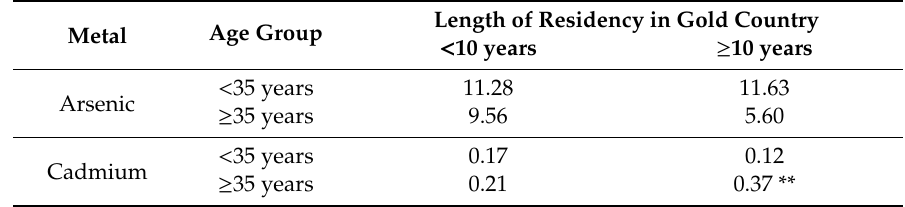
Table 4. Geometric Mean Arsenic and Cadmium levels by length of residence in Gold Country and age